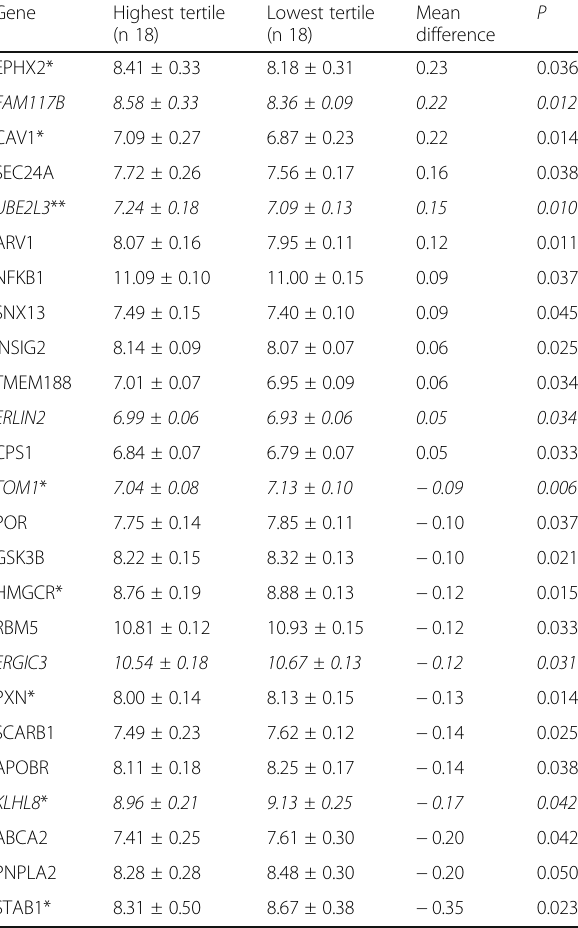
Table 3 Differentially expressed genes between subjects in the highest and lowest plasma n-6 tertile